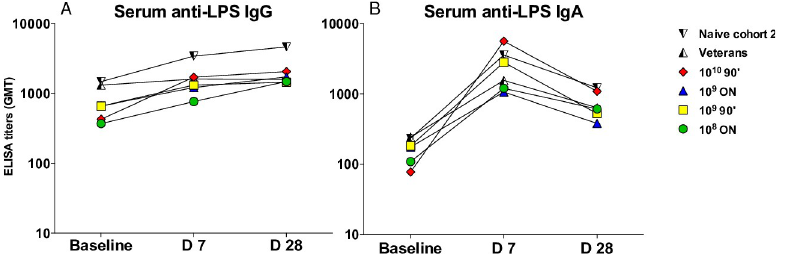
Fig 5. Serologic responses over time to LPS following B7A challenge. (A) IgG anti-LPS; (B) IgA anti- LPS. IgG and IgA antigen-specific responses were evaluated by ELISA before the oral challenge (baseline), and 7 and 28 days later. Graphs represent GMT per time point per